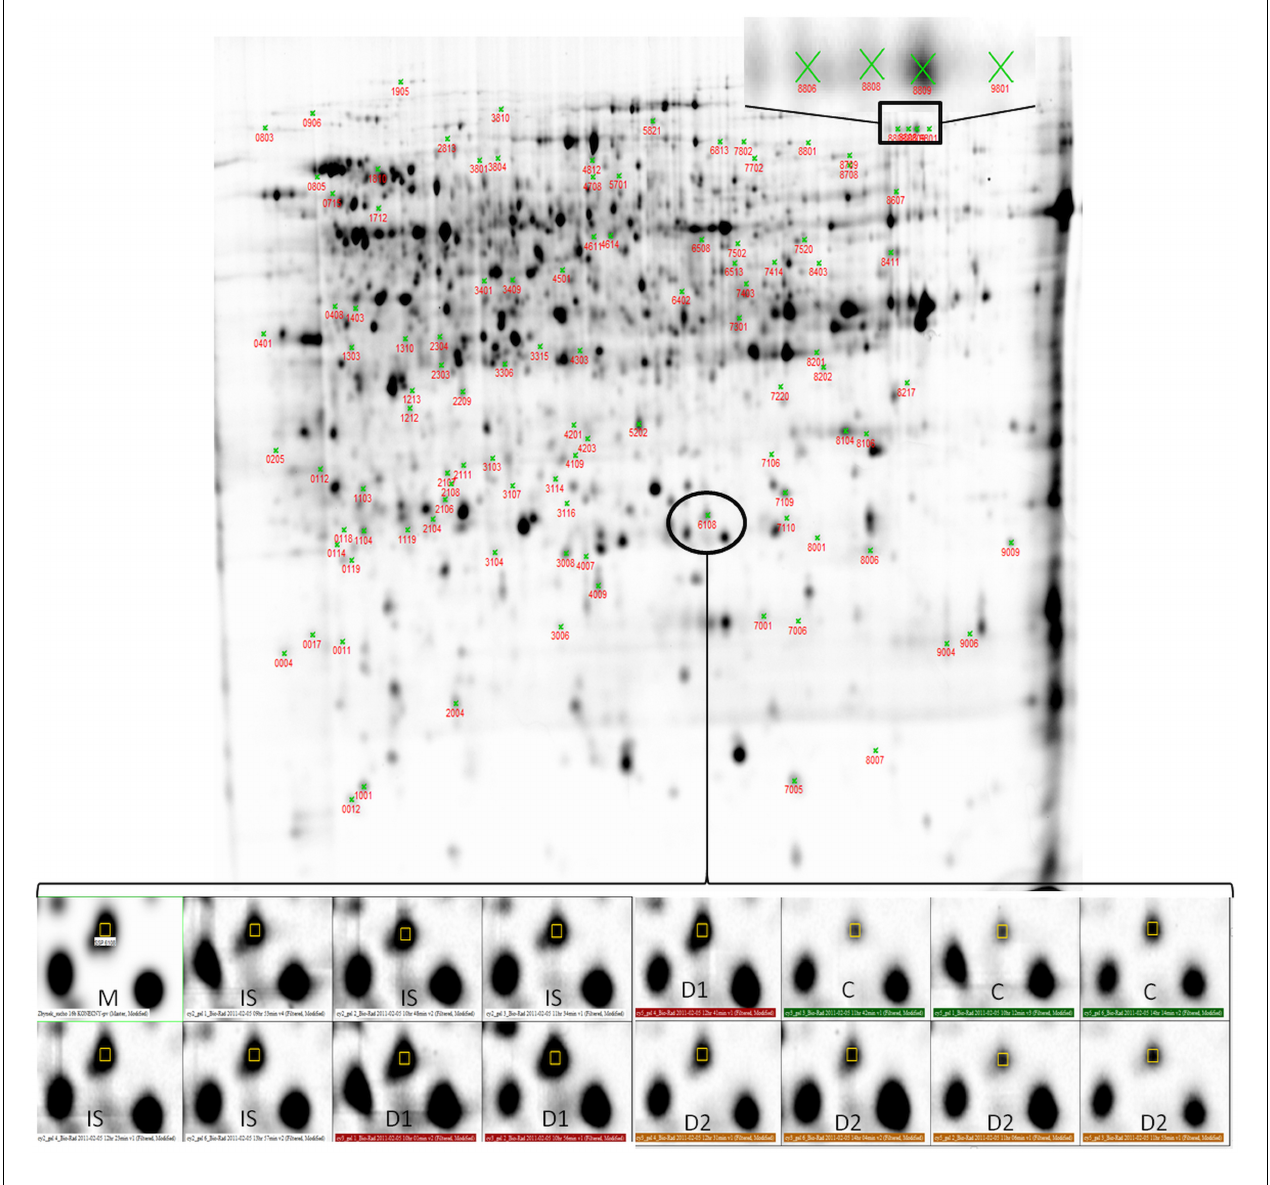
at least 2-fold change in relative abundance between control and drought-treated plants) selected for protein